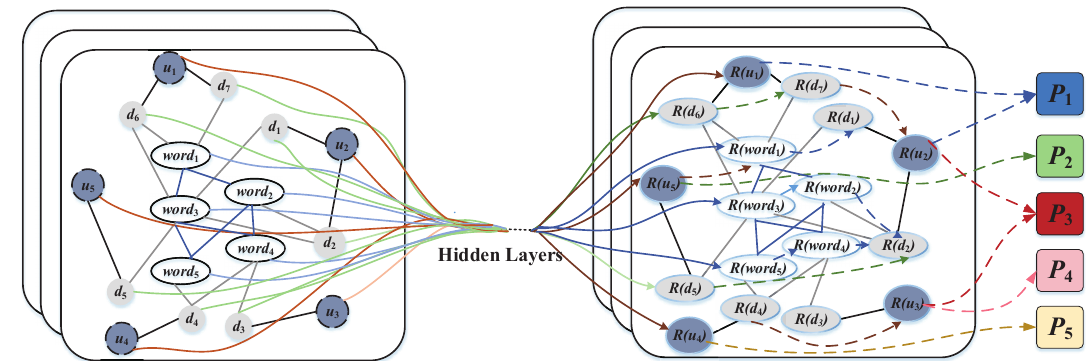
Figure 2. Constructed graph of personality GCN. Nodes beginning with “ u ” stand for user nodes, “ d ” for document nodes, and “ w ” for word nodes. Black edges indicate user-document edges, gray edges document-word edges, and blue edges word-word edges. R ( x ) denotes the representation